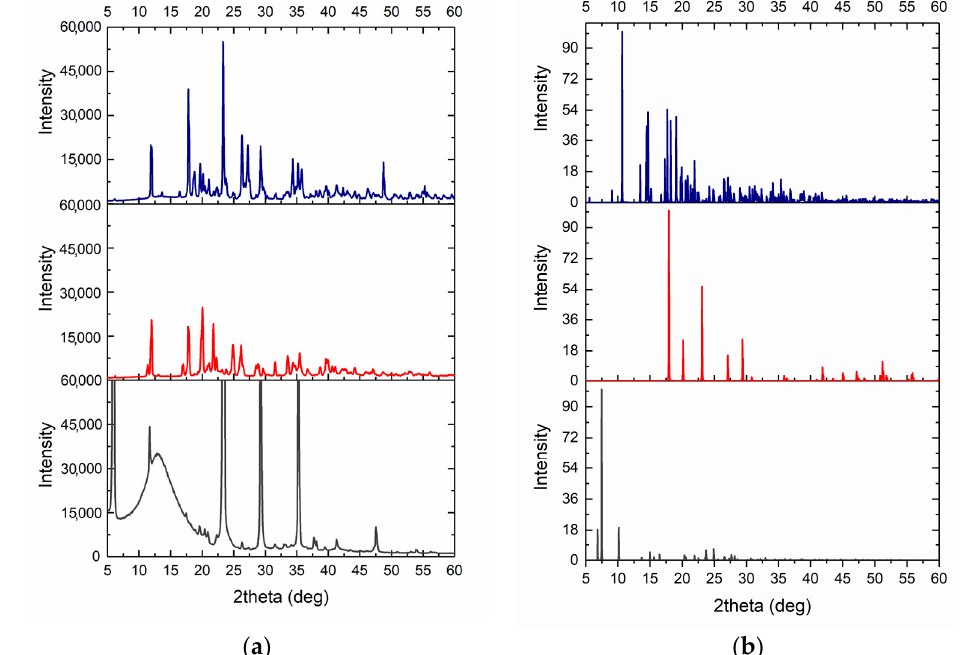
Figure 11. Obtained XRD pattern of synthesized Zn(Met) 2 (red) and crystallized Zn(Met) 2 (SO 4 ) x (blue) complexes and recrystallized L-Methionine (gray) ( a ) and corresponding simulated XRD patterns ( b ).